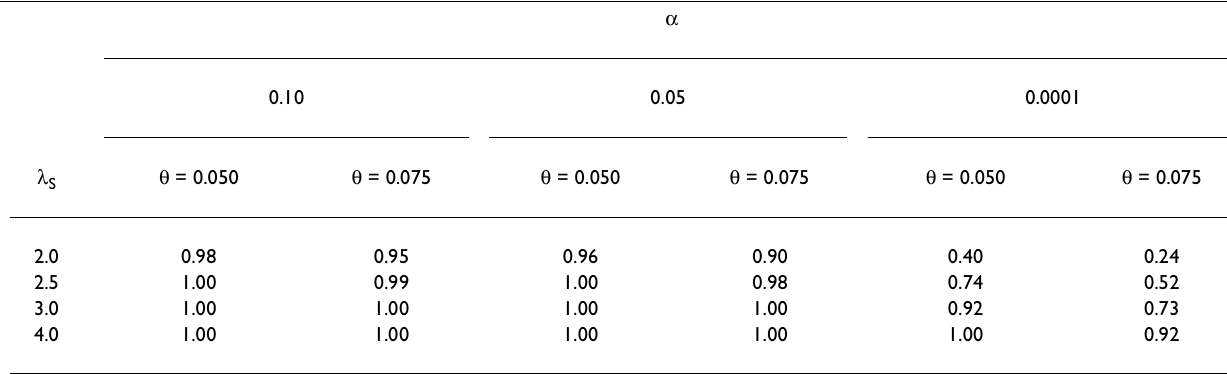
Table 3: Power to Detect Linkage as a Function of λ S , θ , and Type I Error Rate ( α